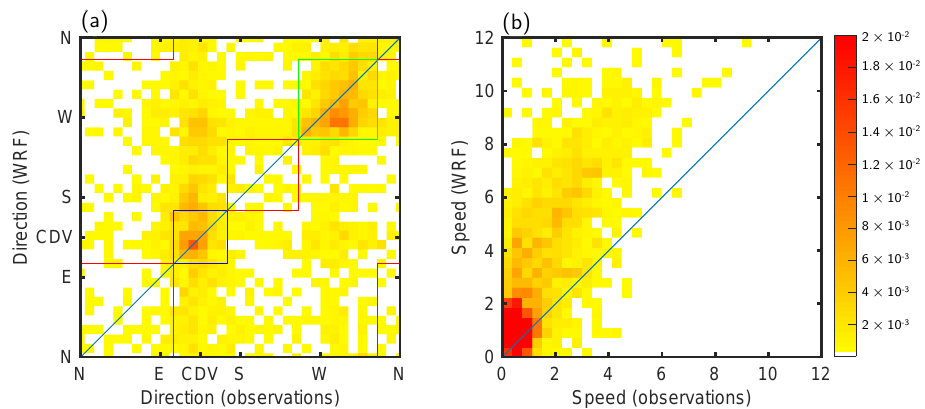
Figure 8. Probability density showing a comparison between WRF and observed winds at MET01 (2m) for ( a ) wind direction and ( b ) wind speed. CDV indicates the Cadarache downvalley direction. Square colors correspond to colored areas in Figure